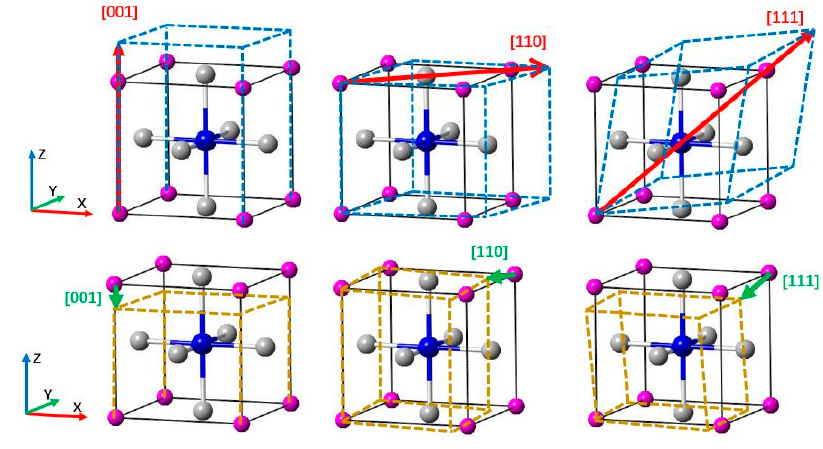
Figure 5. The diagram of tension and compression.